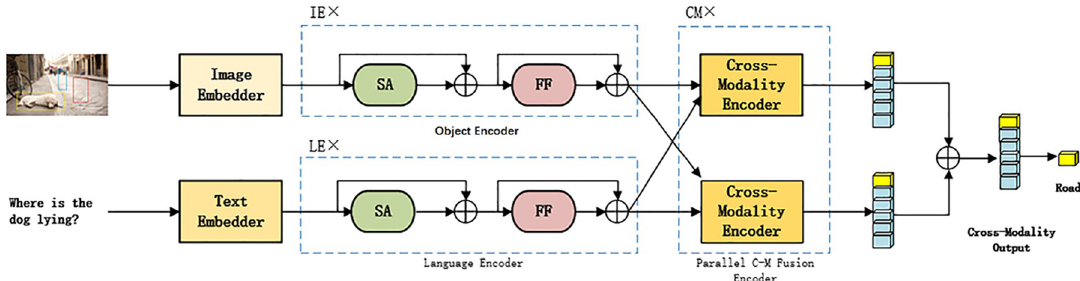
Fig 4. P-PCFL pre-training tasks structure. On the right side of the figure we show the results of five pre-training tasks For pictures of dogs, reprinted from [VQA Consortium] under a CC BY license, with permission from [VQA Consortium], original copyright